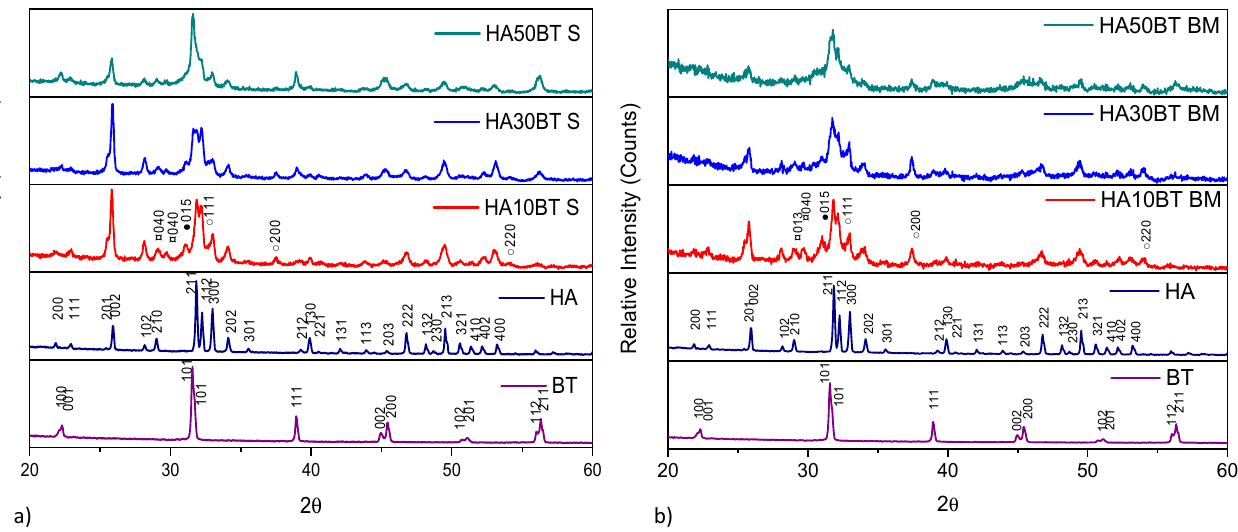
Figure 5. XRD patterns of primary powders vs. different weight HA/BT mixes coatings: ( a ) coatings development using MSH obtained by homogenization process and ( b ) coatings development using high energy ball milling powder obtained by homogenization process.